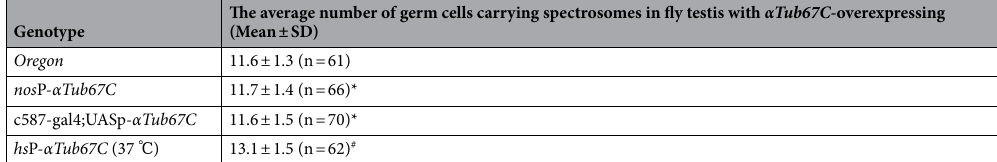
Table 3. The analyses of the average number of germ cells carrying spectrosomes in αTub67C -overexpressing testes. SD, standard deviation. n, Number of examined testes. * P > 0.05, # P < 0.05 unpaired t -test, compared to Wild-type at day 5